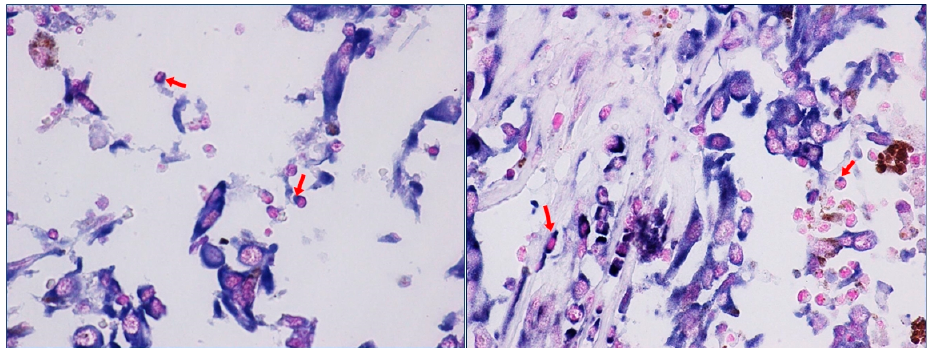
Figure 1. HOTAIR expression in immune cells within tumor microenvironment of a melanoma sample. The red arrows indicate membrane projections in which HOTAIR staining is predominantly concentrated (magnification 40×).